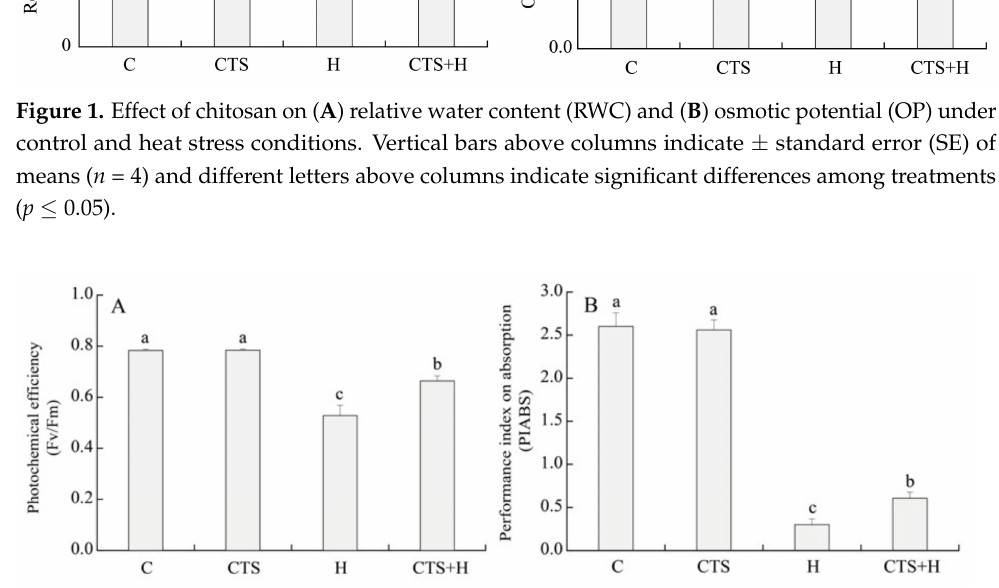
Figure 2. Effect of chitosan on ( A ) photochemical efficiency (Fv/Fm) and ( B ) performance index on absorption basis (PIABS) under control and heat stress conditions. Vertical bars above columns indicate ± standard error (SE) of means ( n = 4) and different letters above columns indicate significant differences among treatments ( p ≤